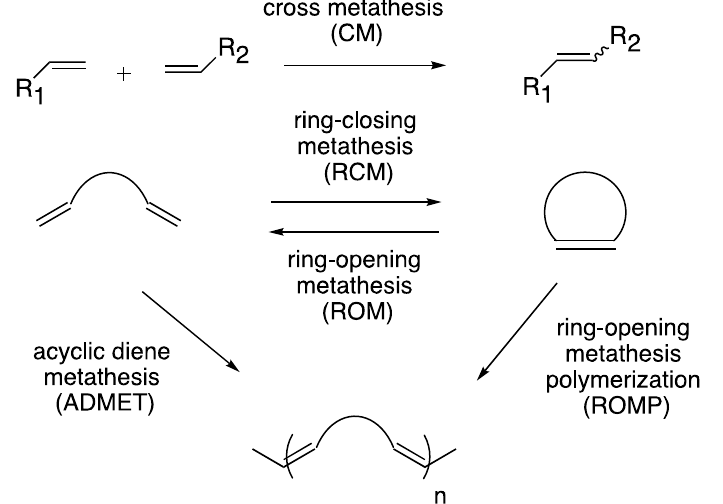
Scheme 1. Reaction fashions of olefin metathesis.